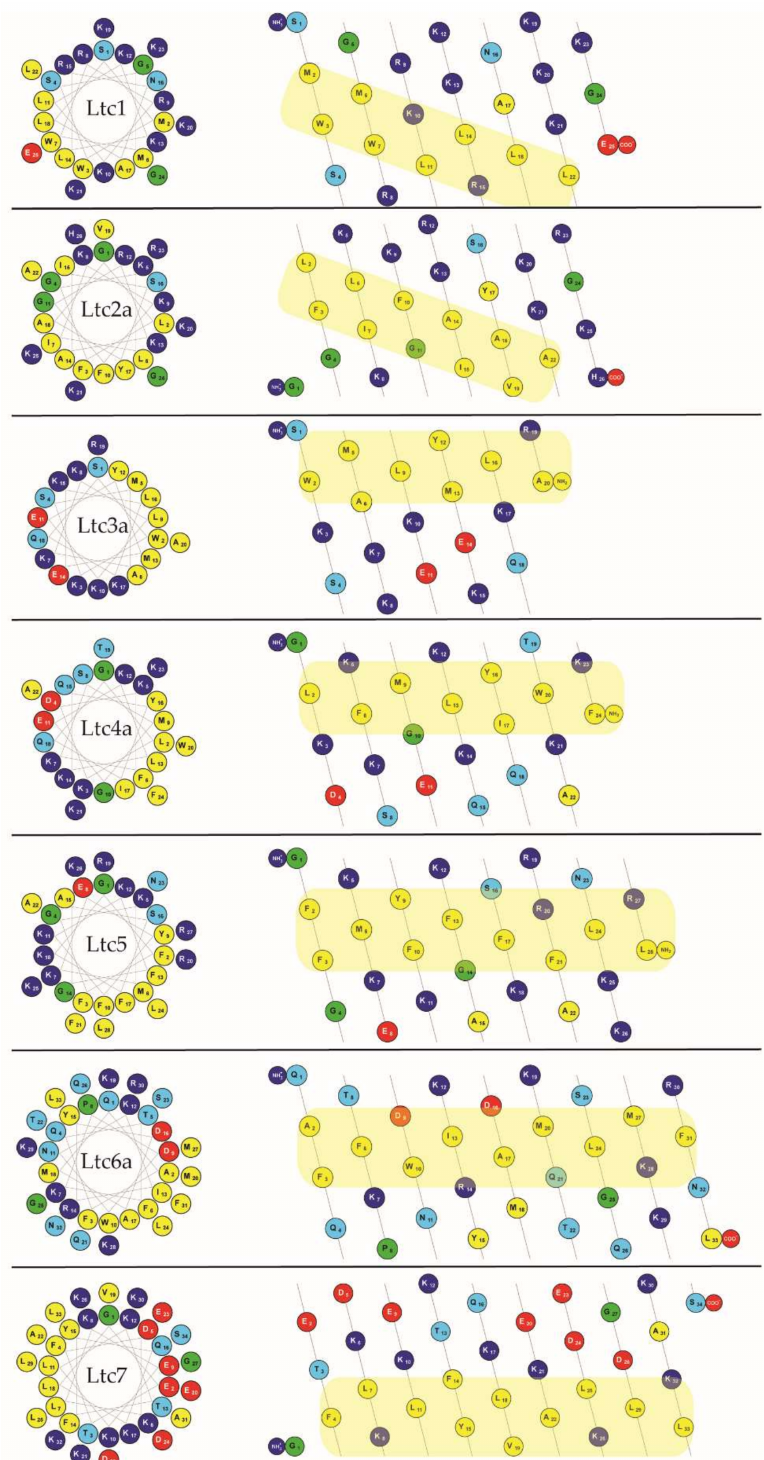
Figure 1. Helical wheels and helical meshes of the amphiphilic latarcin peptides (prepared using the Protein Origami web application found at http://www.ibg.kit.edu/protein_origami/ [15]). It is assumed that the peptides are fully helical (see text), and the hydrophobic face has been highlighted in yellow. Residues are color-coded: yellow—hydrophobic; light blue—polar; dark blue—cationic; red—anionic;